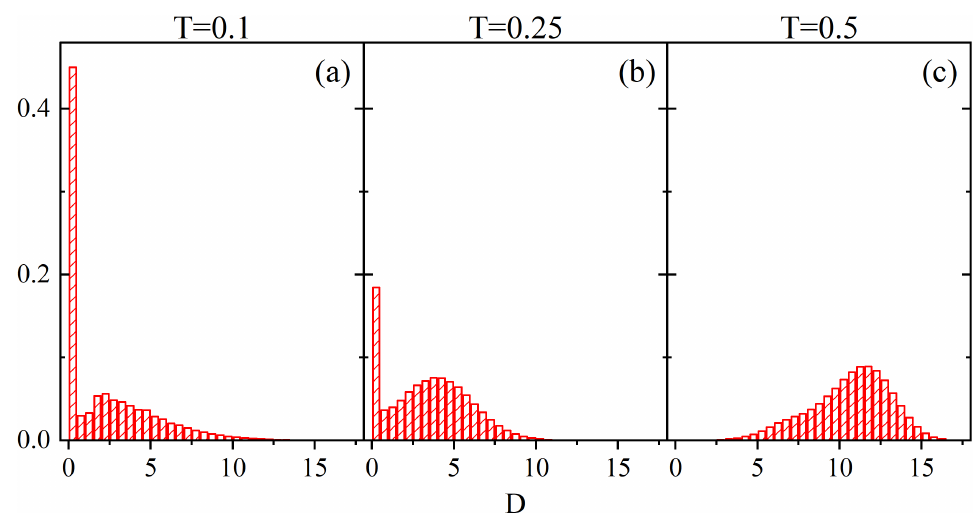
Figure 13. Normalized empirical probability distributions ρ ( D ( (cid:126) r )) for T = 0.1 ( a ), T = 0.25 ( b ) and T = 0.5 ( c ).